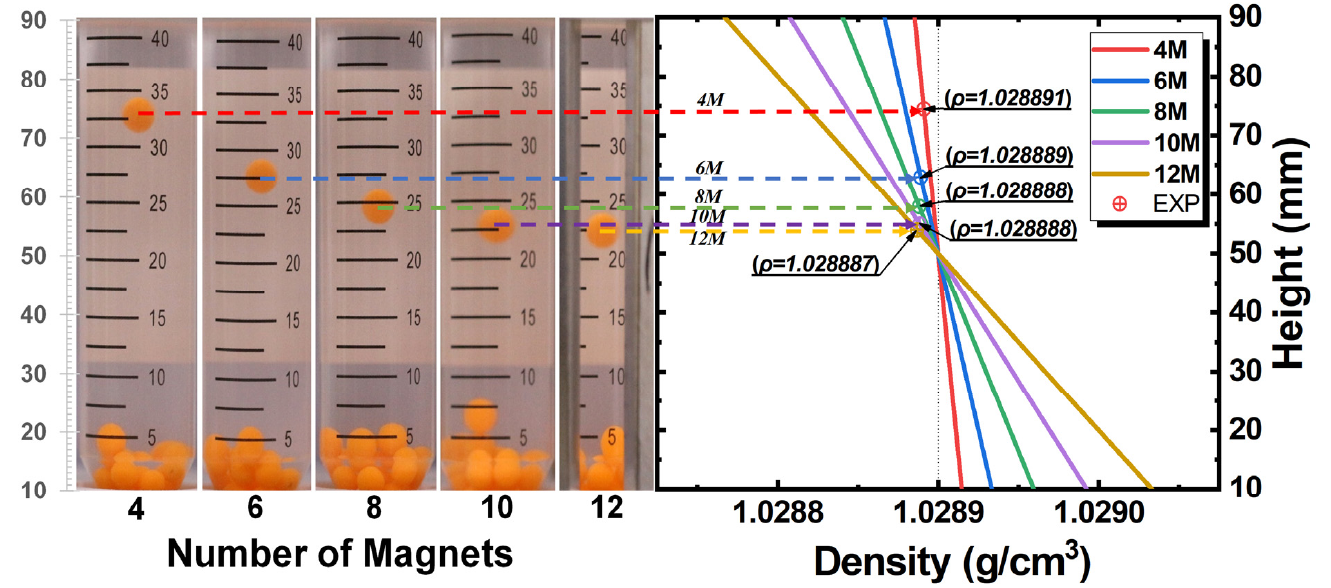
Figure 4. Density measurements using the M-MagLev system. Left part is captured photographs of the polystyrene bead levitated in M-MagLev with 4, 6, 8, and 10 magnets, respectively. Right part is the mapping of levitation height and the density of the bead for the corresponding M-MagLev according to the theoretical model. Symbols are the experimental results, while lines are the simulation results.